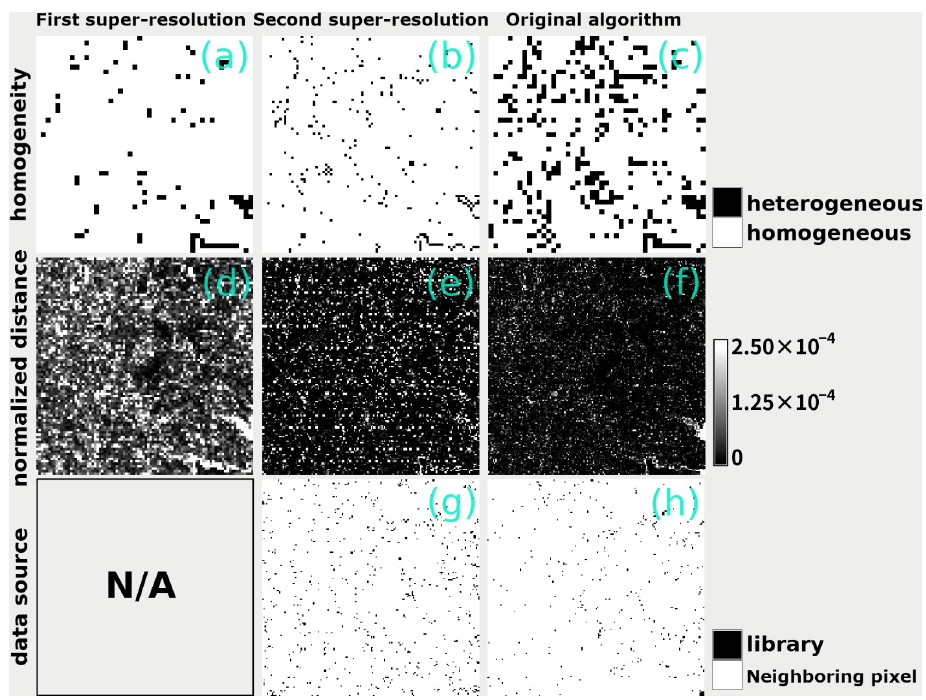
Fig 9. Maps describing characteristics of super-resolution retrieval. From the top row, pixel homogeneity, Mahalanobis distance, and data sources (the typical spectral pattern or neighboring pixel used in the retrieval process) are displayed. The left and center columns show the maps for the first and the second super-resolution retrievals by our proposed Algorithm 3, respectively. The right column shows retrieval by the original Algorithm 1.